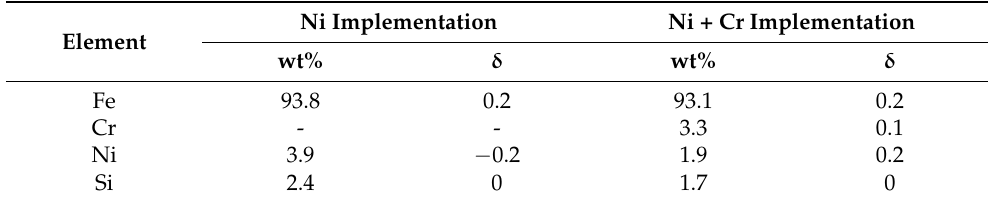
Table 1. The percentage of elements after implementation of nickel and combination of nickel and chromium.